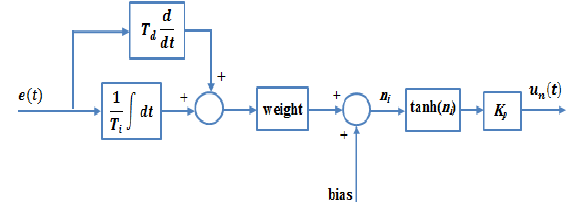
Fig. 8. Single input-single output NID controller